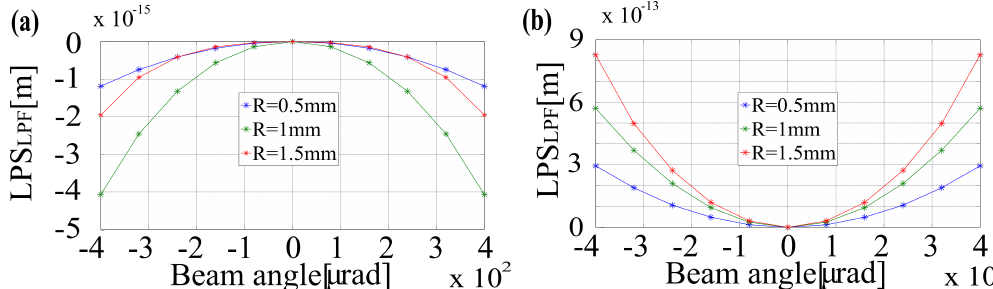
Figure 5. The TTL couplings shown in ( a , b ) are slightly different because of different optical parameters, but they are below the picometer